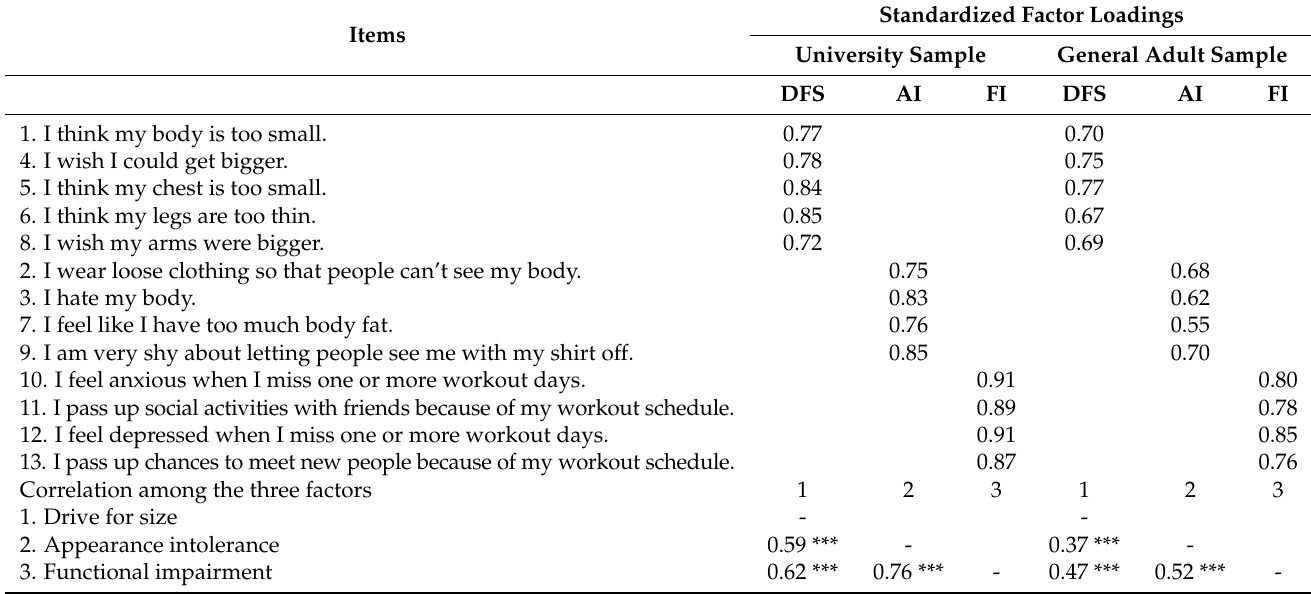
Table 3. Standardized factor loadings and factor correlations for the Muscle Dysmorphic Disorder Inventory.